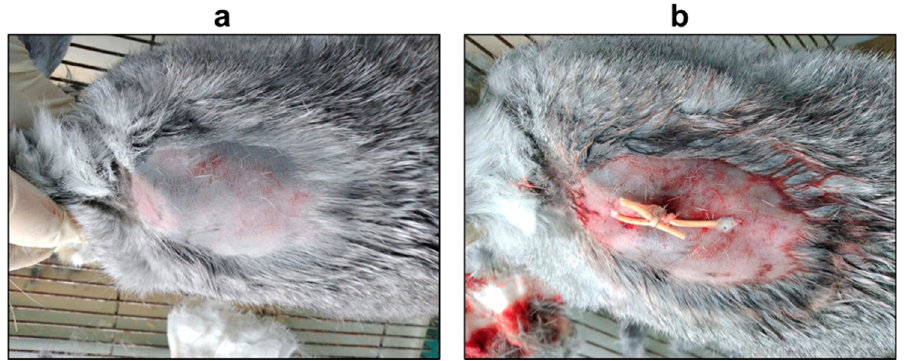
Figure 2. Withers abscess formation in rabbits caused by F. necrophorum ( a ) and animals with placed drainage ( b ).